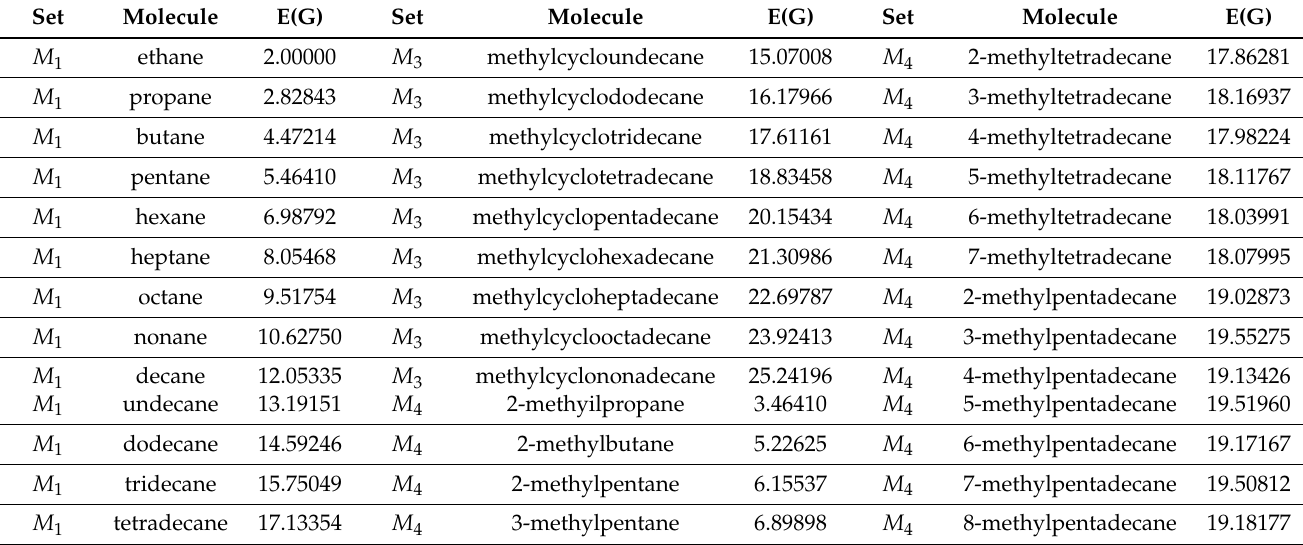
Table A5. The graph energy of considered molecular